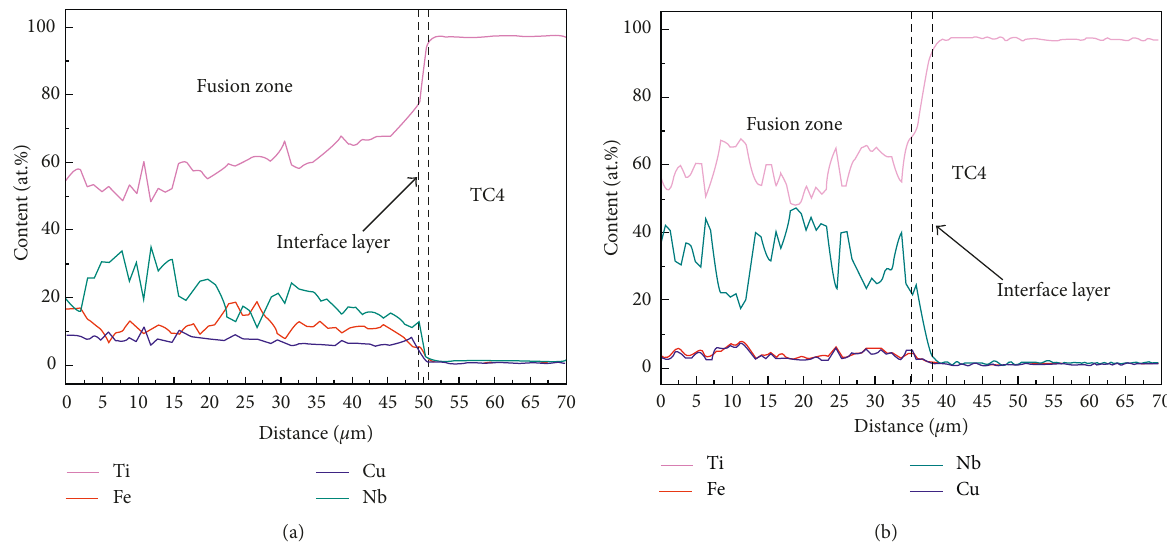
Figure 6: Elemental profiles of Ti, Nb, Cu, and Fe between the fusion zone (left) and the titanium alloy side (right): (a) EBW-1; (b) EBW-2.